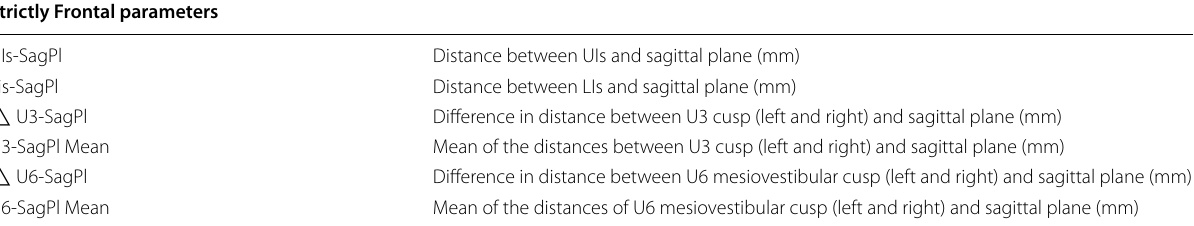
Table 8 Frontal dento-alveolar analysis: frontal parameters Strictly Frontal